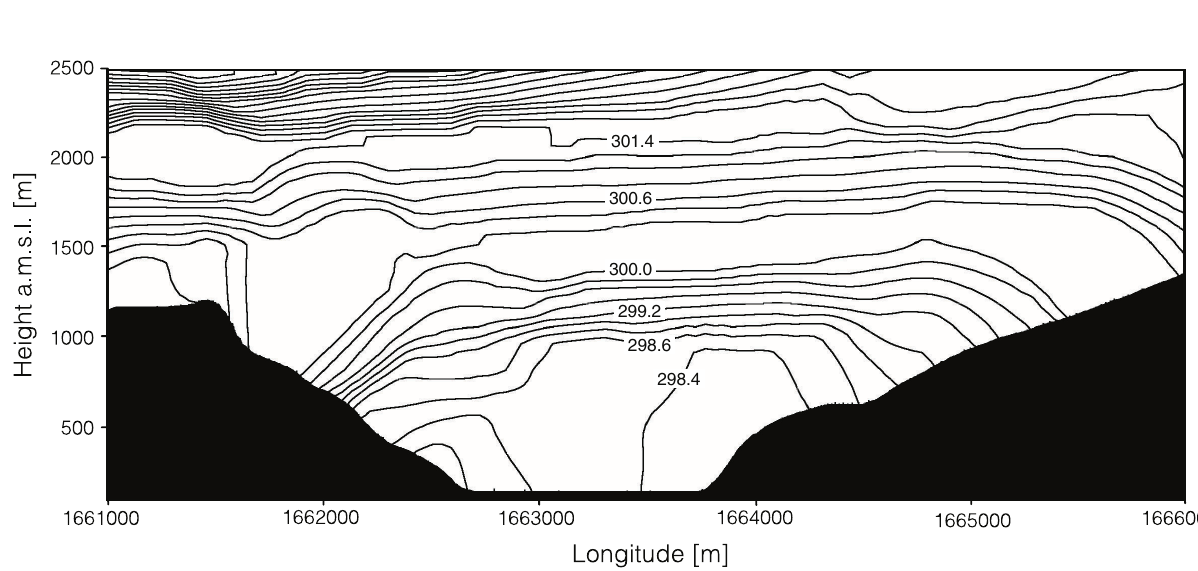
Fig. 11. Mapping of virtual potential temperature q measurements collected during the fl ight